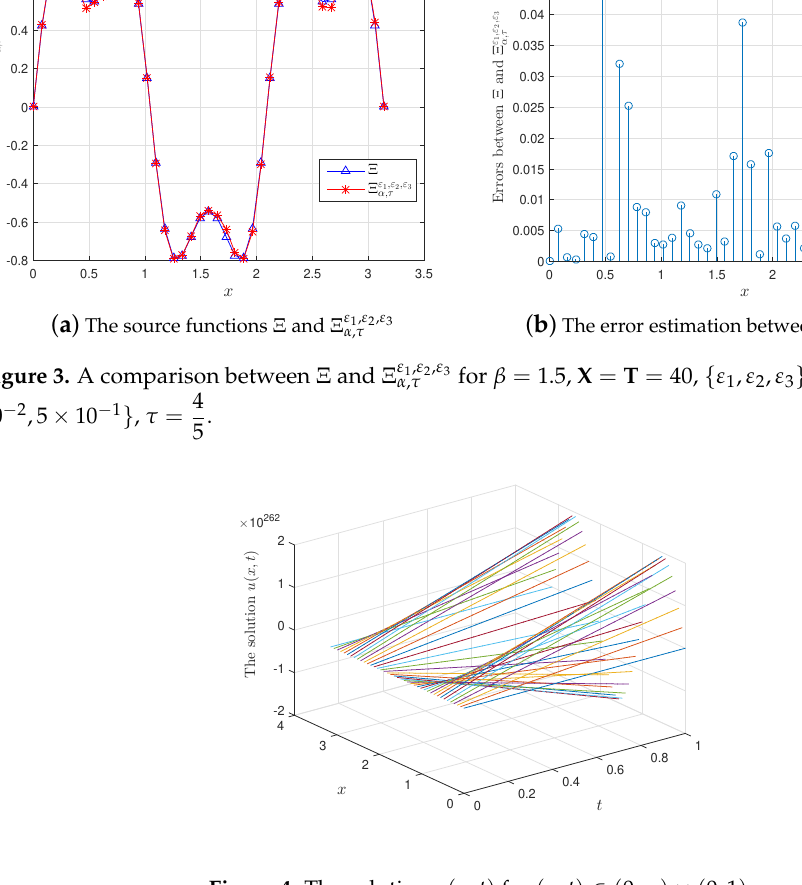
Figure 4. The solution u ( x , t ) for ( x , t ) ∈ ( 0, π ) × ( 0,1 ) . Table 1. The errors estimation between Ξ and Ξ ε 1 , ε 2 , ε 3 α , τ at β = 1.5 with X = T = 40, τ =